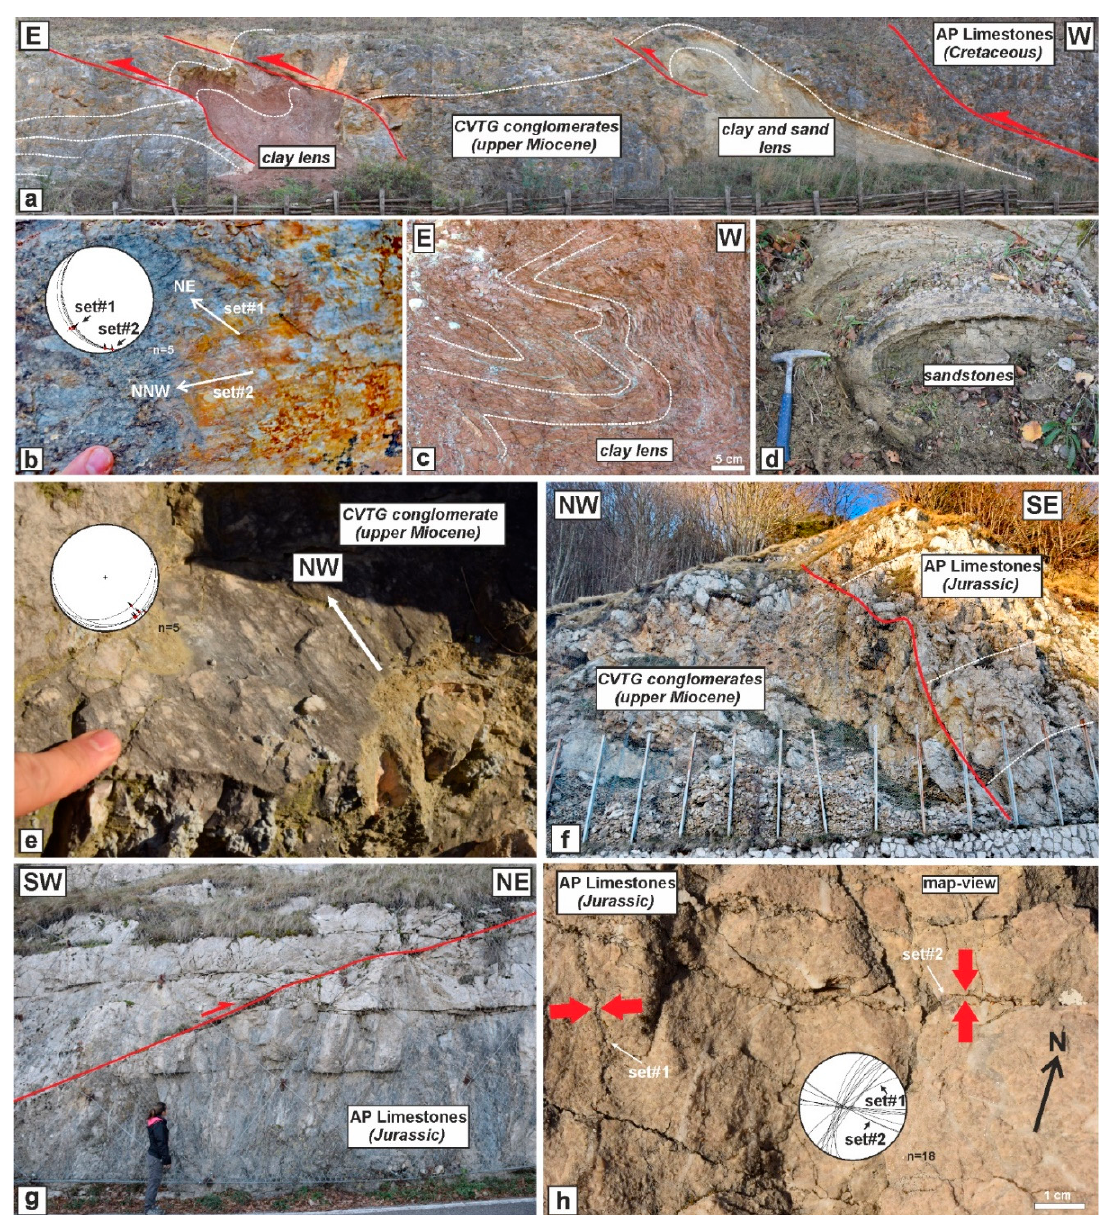
Figure 7. Pietra Maula: ( a ) imbricate fan of thrust sheets superposing Apennine Platform (AP) limestones onto CVTG conglomerates, sandstones and clays; ( b ) thrust fault plane showing two sets of slickenside striations and steps; ( c ) folds in CVTG clays; ( d ) fold in the CVTG sandstones. ( e ) Thrust plane showing striations and steps indicating an N vergence (Mt Faggeto). Montevergine: ( g ) high-angle thrust of AP Jurassic limestones onto CVTG; ( h ) two orthogonal stylolite sets in AP Jurassic oolitic limestones.